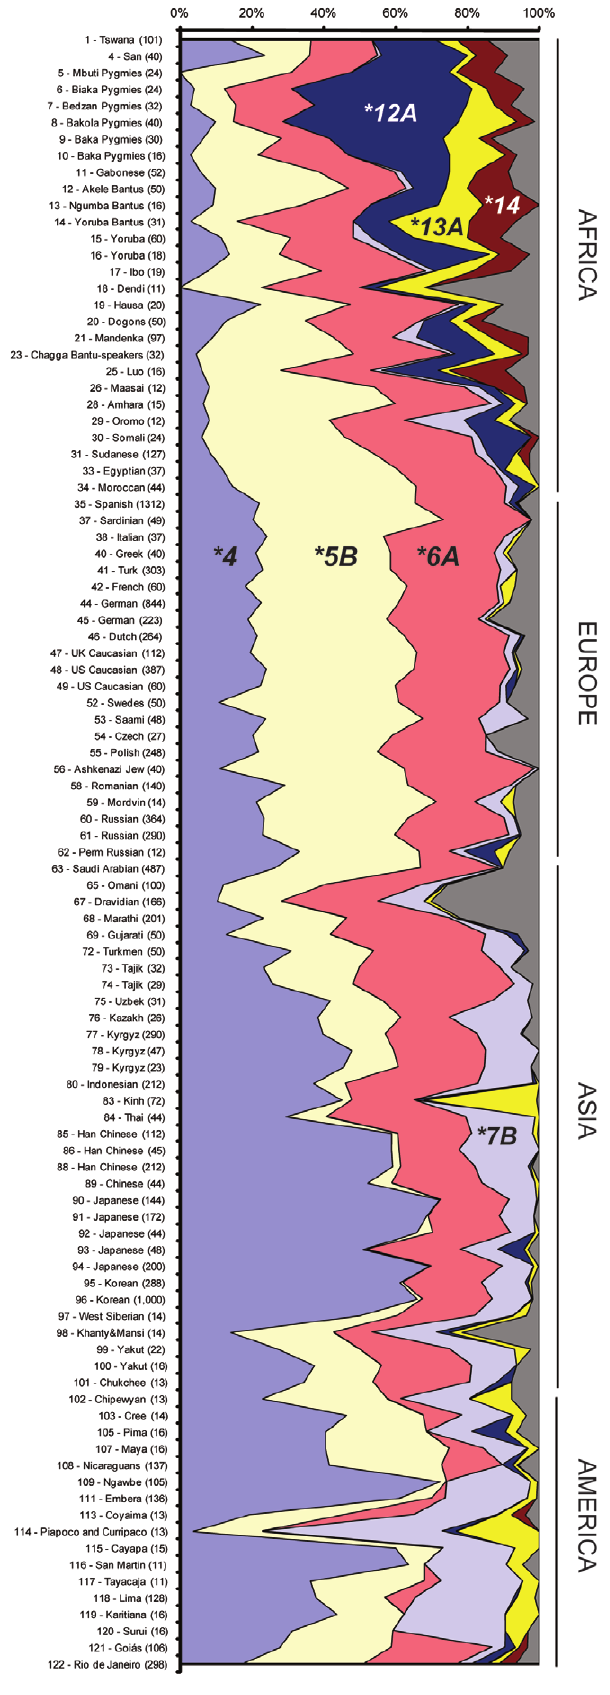
Figure 2. Distribution of NAT2 haplotype frequencies in the 99 population samples included in the worldwide diversity survey. The 99 samples included 74 samples genotyped for the seven most common SNPs of NAT2 as well as 25 non-African samples genotyped for all SNPs except the 191G . A variant. Single populations are reported on the left side of the plot, with sample ID (as reported in Table S1) preceeding the population name and sample size (number of individuals) in brackets; geographic areas are indicated on the right side. The assignment of populations to one of the four world regions was based on the origin of the population, ignoring the past 1,000 years of known human migration (e.g., people of European descent in the United States were assigned to Europe). Only haplotypes with frequencies above 5% in at least one continental region are represented individually; all other haplotypes are pooled into a single group (in grey). Also, haplotypes NAT2*14A and NAT2*14B are pooled into the NAT2*14